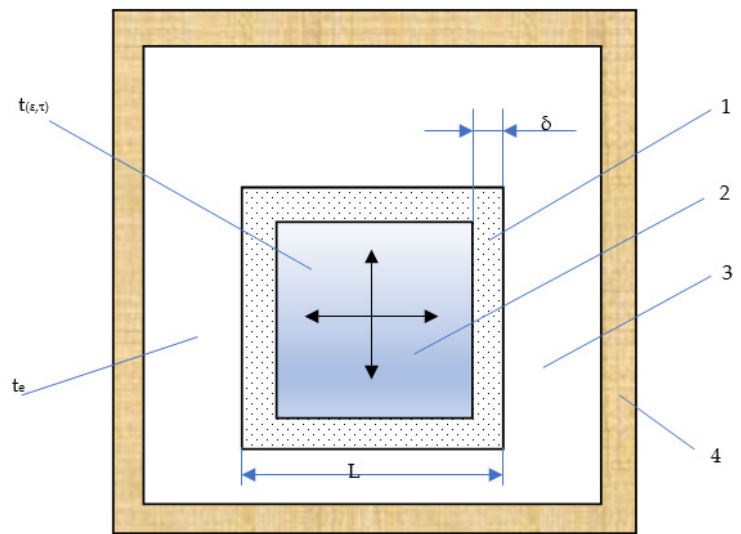
Figure 1. Product cube freezing model: 1—frozen layer, 2—layer of the product that will be frozen, and which has an initial temperature, 3—cooling air, 4—thermal insulation of a mechanized device for small-piece freezing.